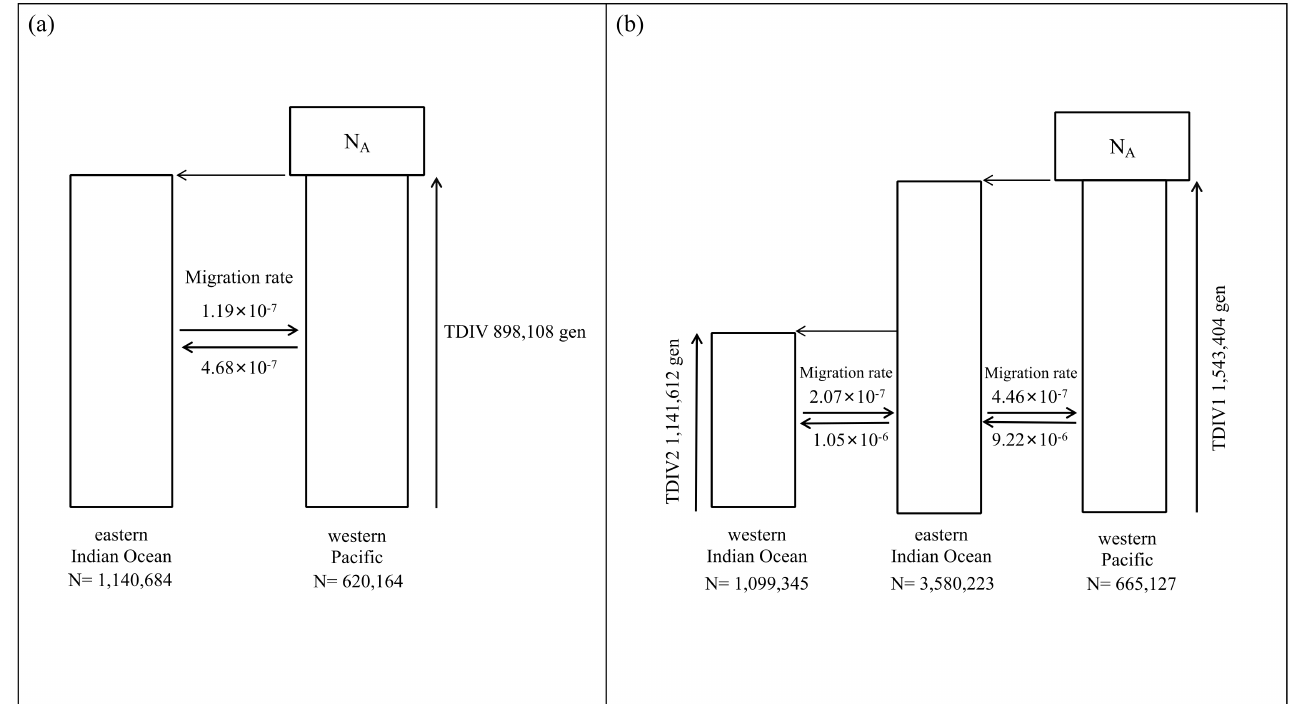
Figure 7. The most probable coalescent models estimated by FASTSIMCOAL2; ( a ) the best of the five models for Pampus chinensis , ( b ) the best of the eight models for P . cinereus . N A indicates the ancestral population size; N indicates the current effective population size; TDIV, TDIV1 and TDIV2 indicate the estimated time (generations) since the populations